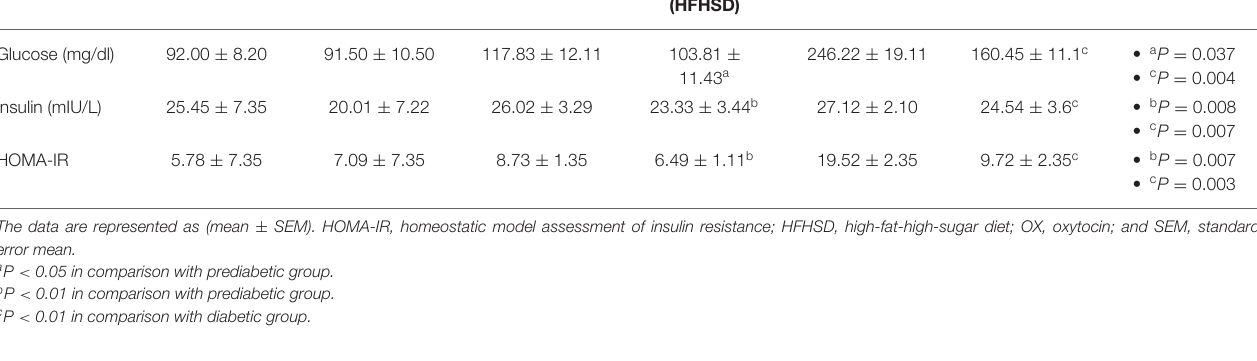
TABLE 2 | Comparison (mean ± SEM) of the hepatic enzymes and the lipid profiles in different groups of Wistar rats. Parameters Control (normal)